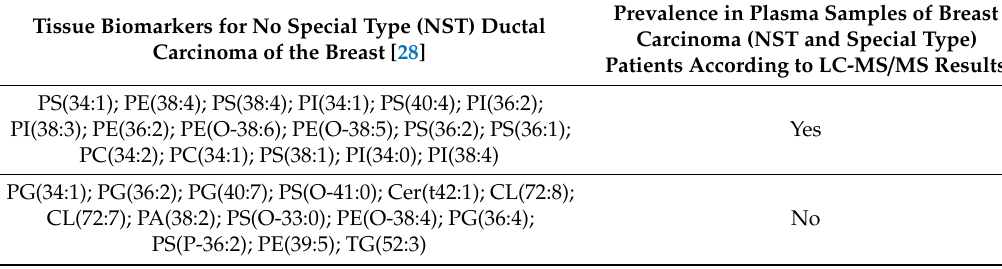
Table2. TissuebiomarkersfoundbyDESI-MSI(Desorption-Electrospray-Ionization—MassSpectrometry Imaging) and their occurrence in plasma samples of breast cancer patients analyzed by LC-MS / MS (Liquid Chromatography—tandem Mass Spectrometry).